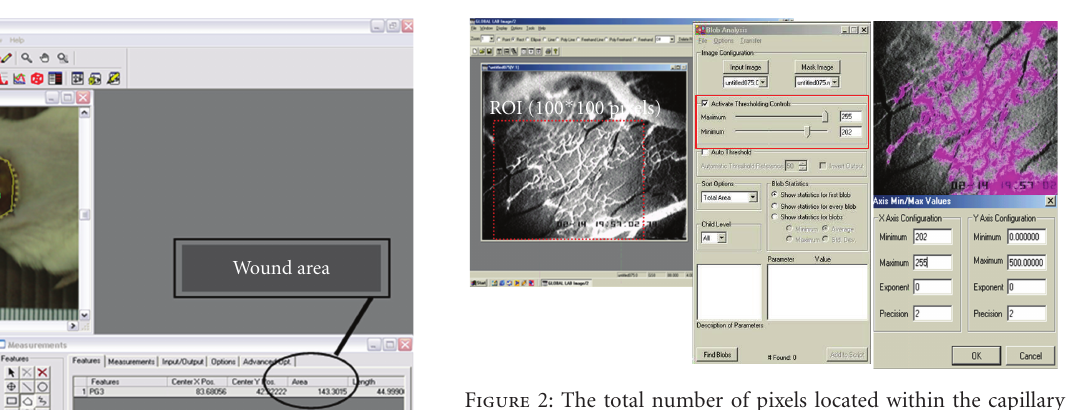
Figure 2: The total number of pixels located within the capillary network of each ROI (100 × 100 pixels) was determined by using Image Pro II